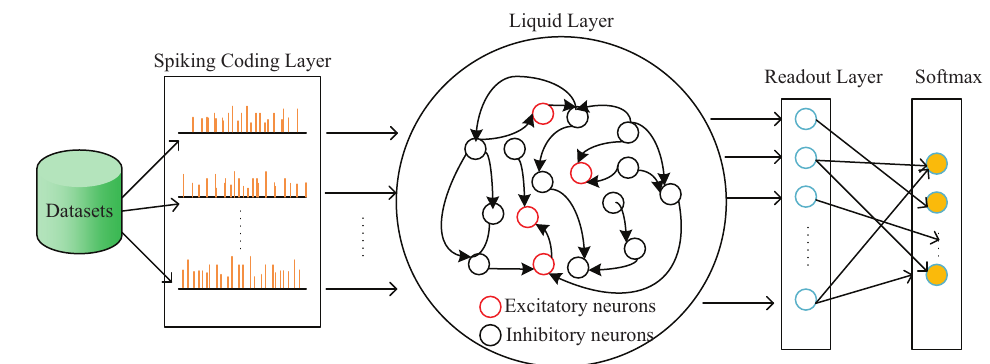
Figure 1. An example of the learning process of the spike neural network supervised learning